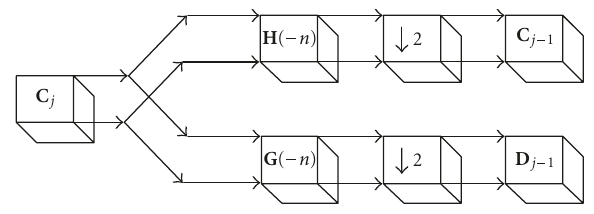
Figure 1: The analysis filterbank for orthogonal multiwavelet trans-